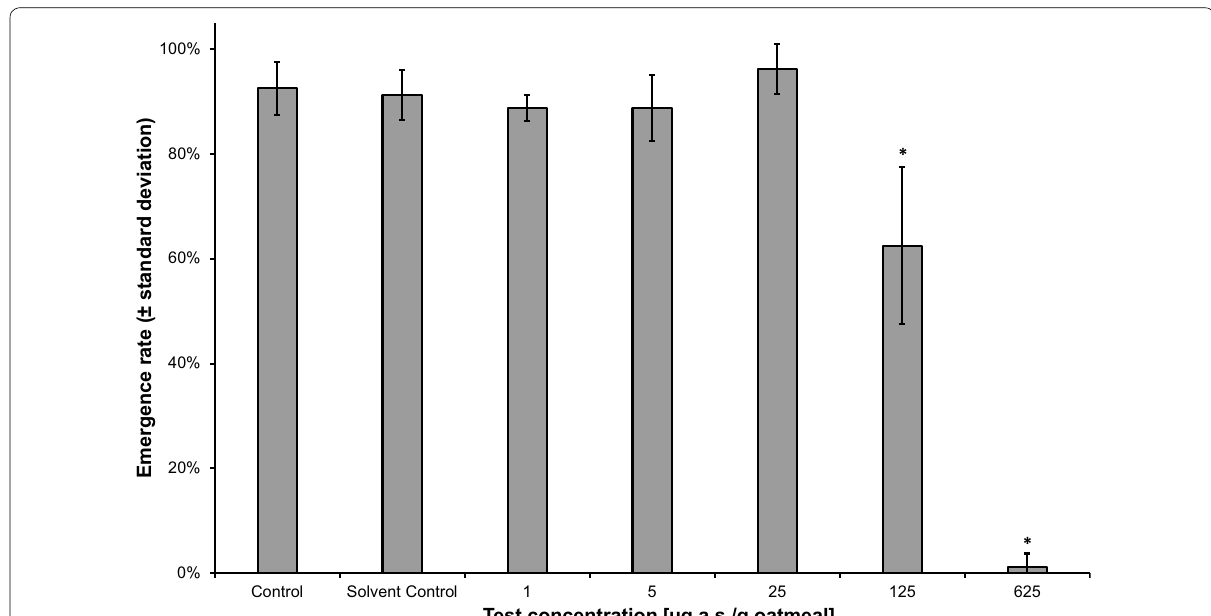
standard deviation) of ±